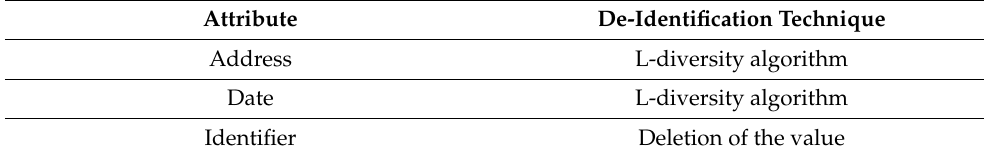
Table 1. Example of the rules for the selection of the de-identification techniques.